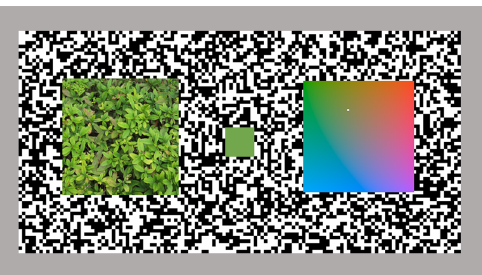
Figure 2. Schematic diagram of the stimulus display in Experiment